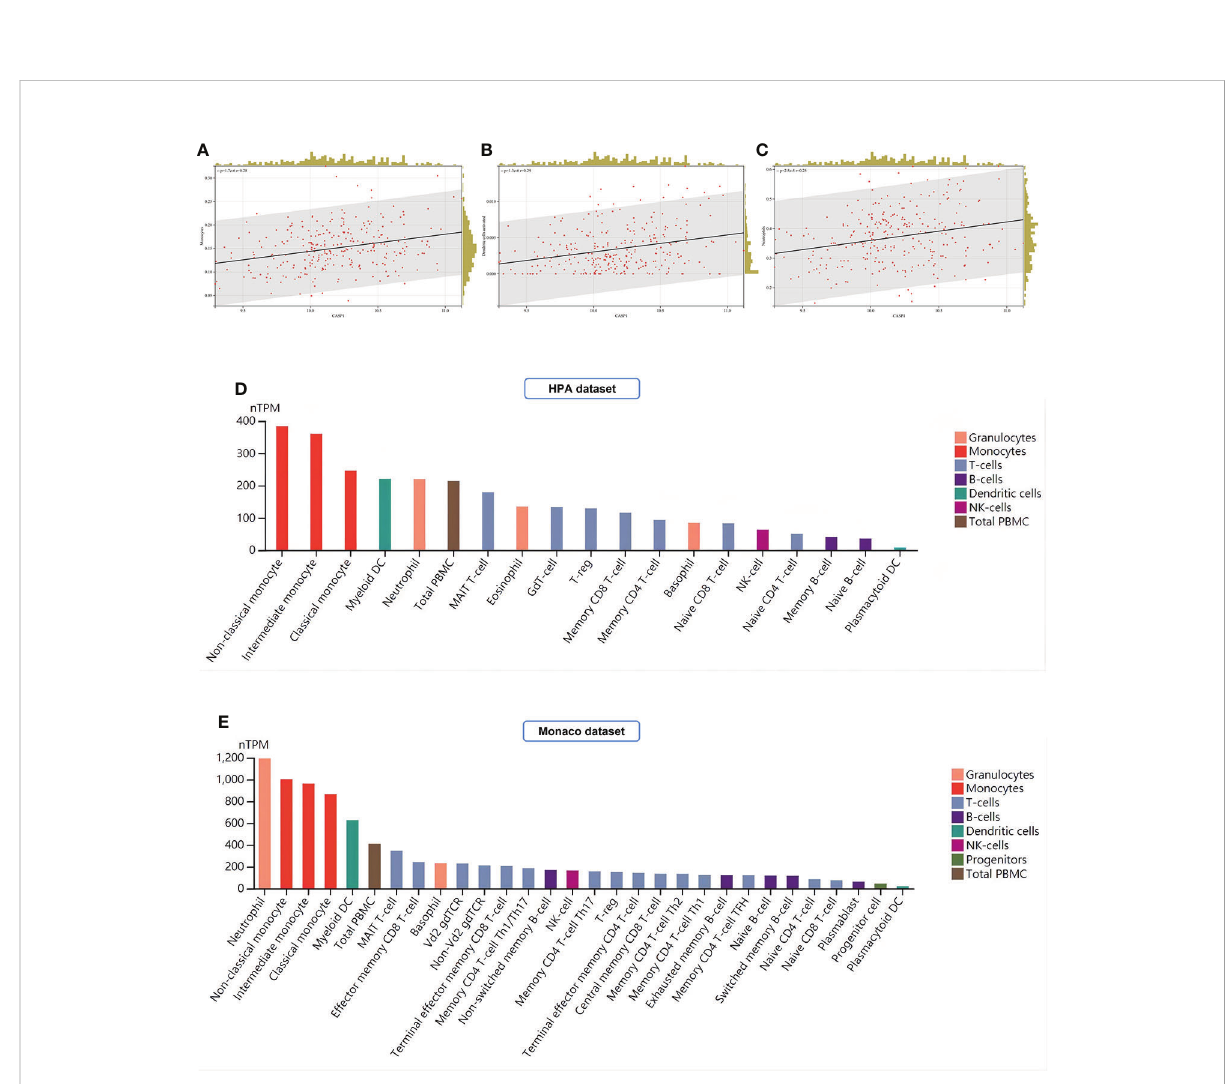
FIGURE 13 Analysis of immune cell in fi ltration. (A – C) Immune in fi ltrating cells positively associated with high CASP1 expression in LM22: Monocytes, Dendritic cells activated, and Neutrophils. (D, E) Distribution of CASP1 expression in immune cells from HPA datasets and Monaco